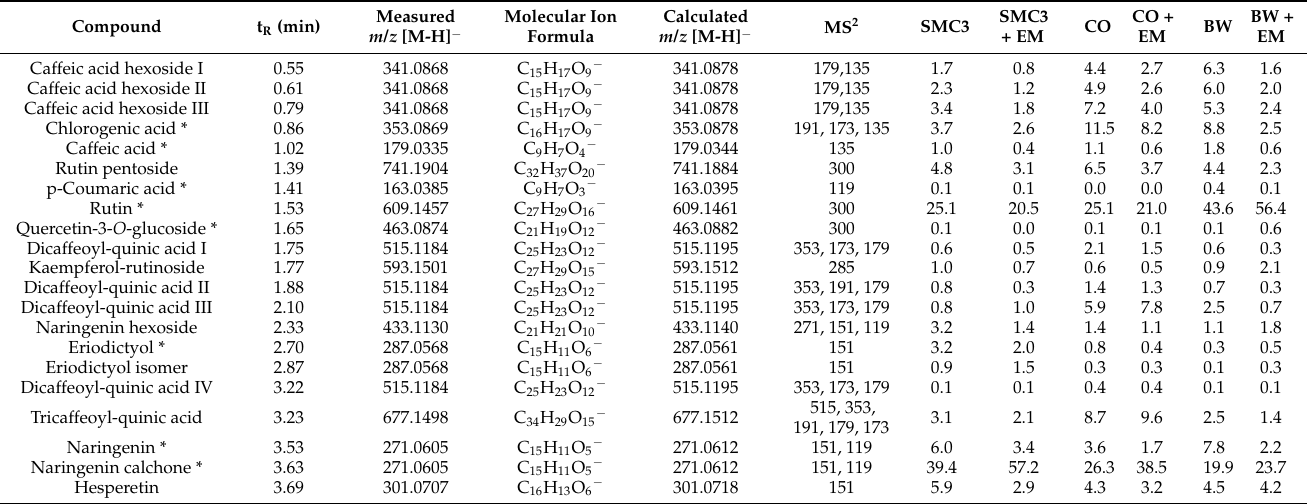
Table 1. Polyphenolic identification in tomato extracts by UHPLC–ESIMS − and relative composition (%) based on peak area integration of the extracted molecular